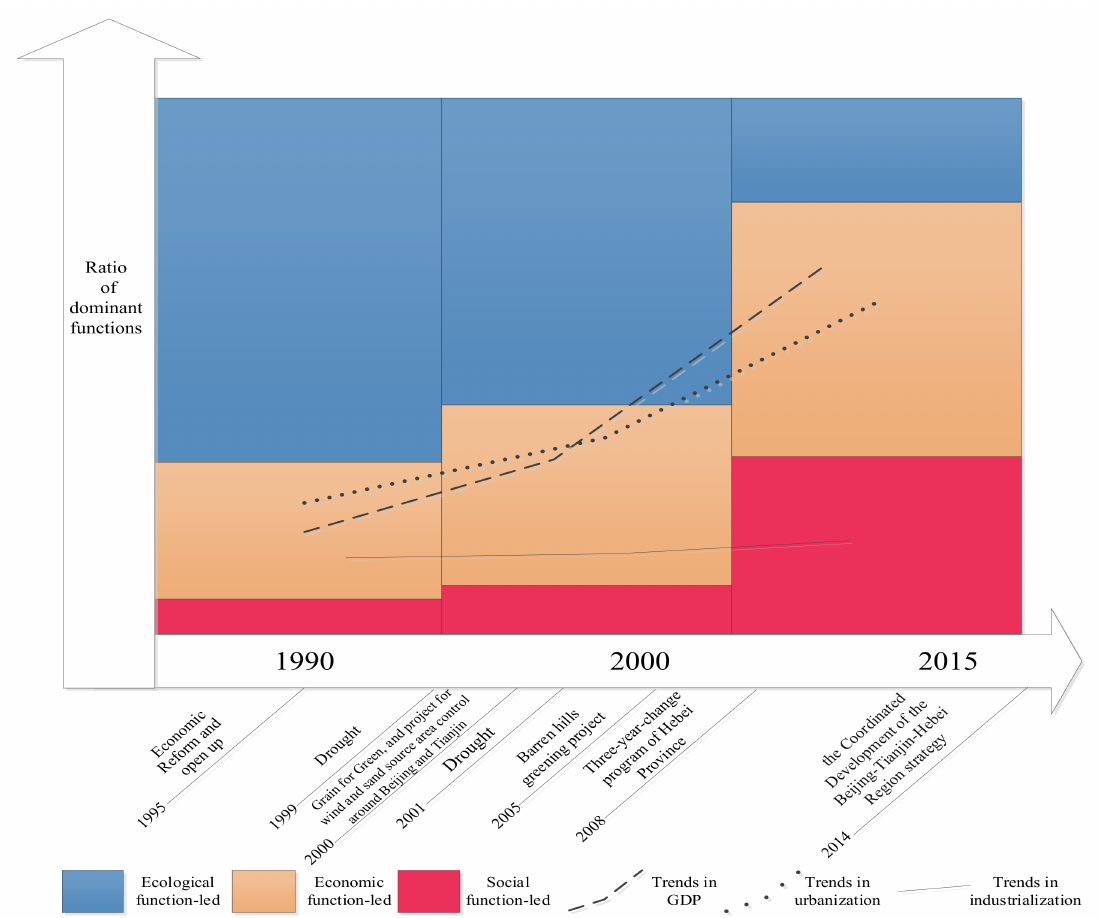
Figure 9. Influencing mechanism for LUFs changes in Zhangjiakou City in